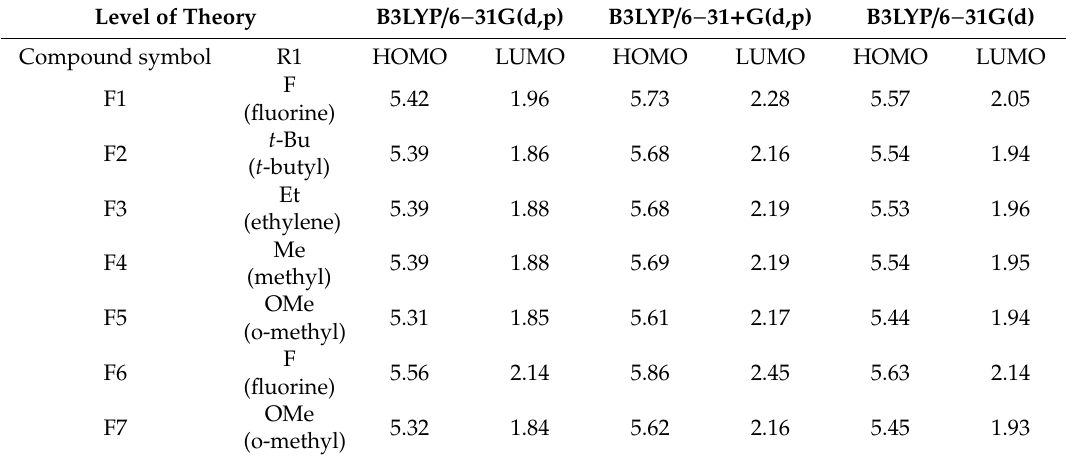
Table 2. Energy HOMO and LUMO levels calculated by TDDFT method by di ff erent levels of theory for investigated compounds F1–F7.